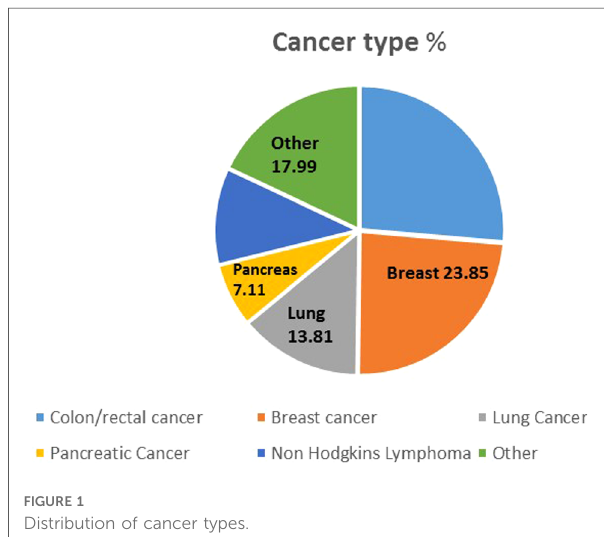
FIGURE 1 Distribution of cancer types.